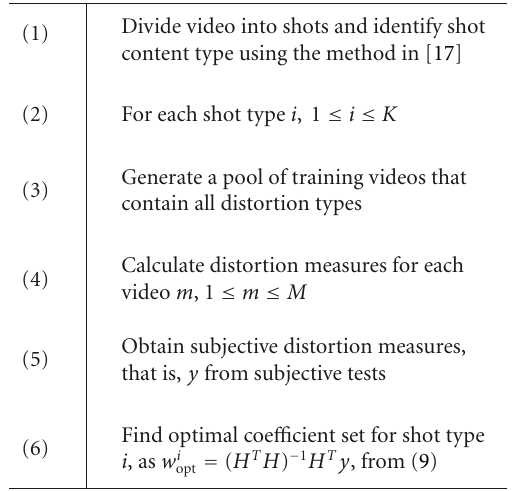
Table 2: Coe ffi cient determination